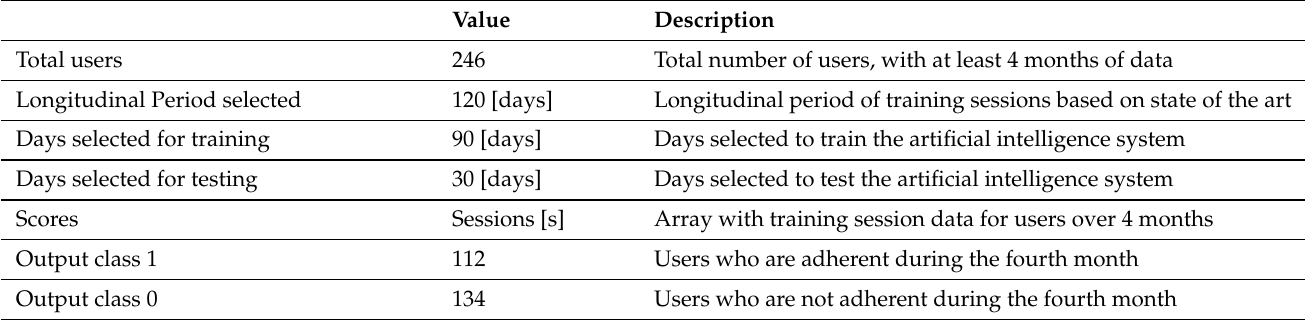
Table 7. Summarised input